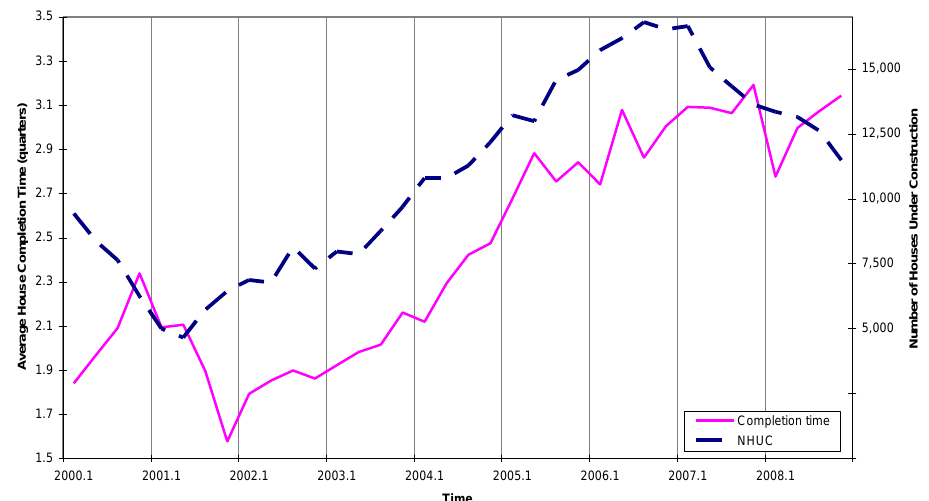
Figure 10: Number of houses under construction and the average house completion time in Western